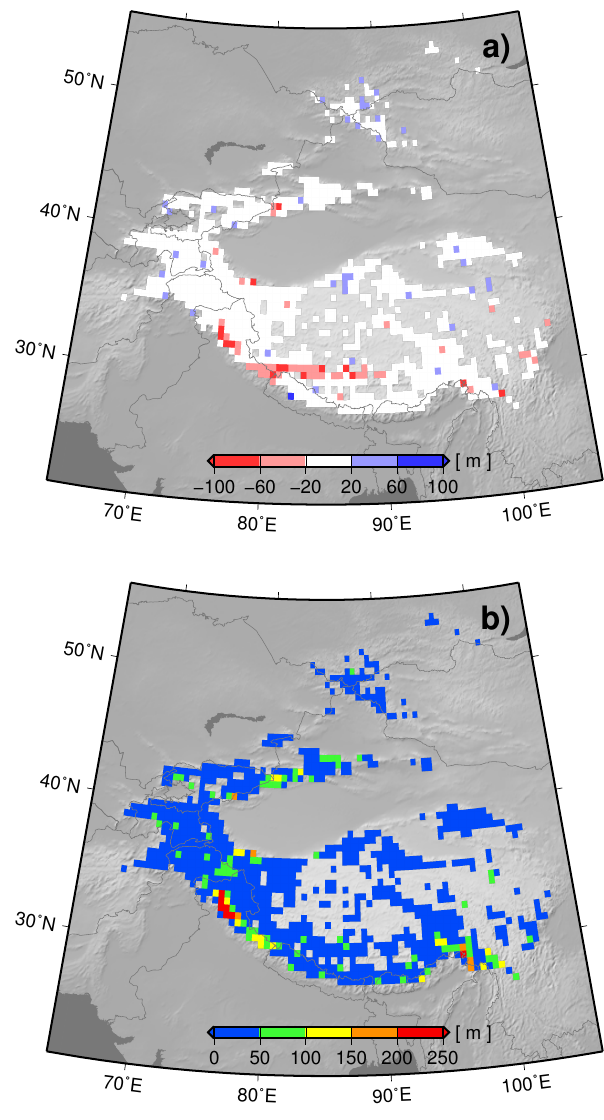
Figure 19. (a) Differences between area-weighted means of median elevations in the GGI derived from SRTM and those from GDEM2 (i.e. SRTM − GDEM2). (b) Standard deviations of the difference in median elevation of each glacier derived by SRTM and GDEM2 models. Grid cell size is 0.5 ◦ for